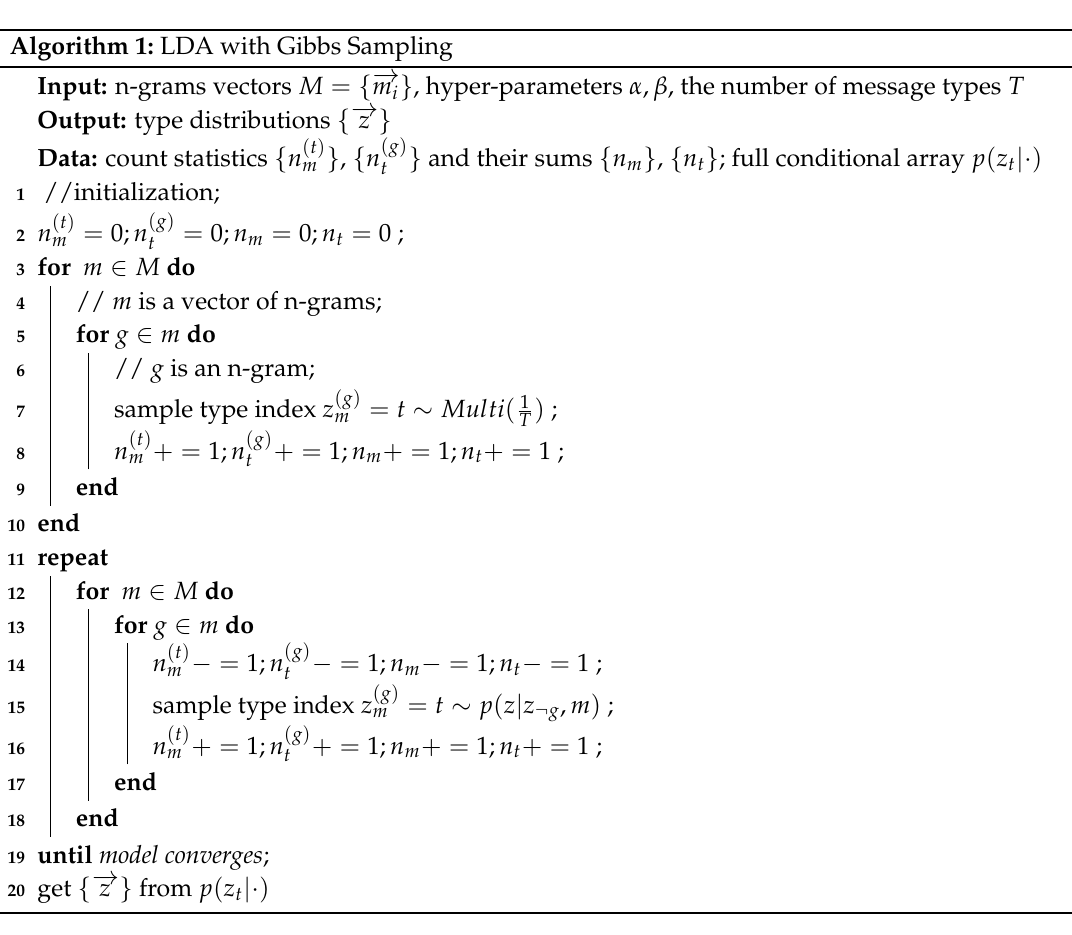
Algorithm 1: LDA with Gibbs